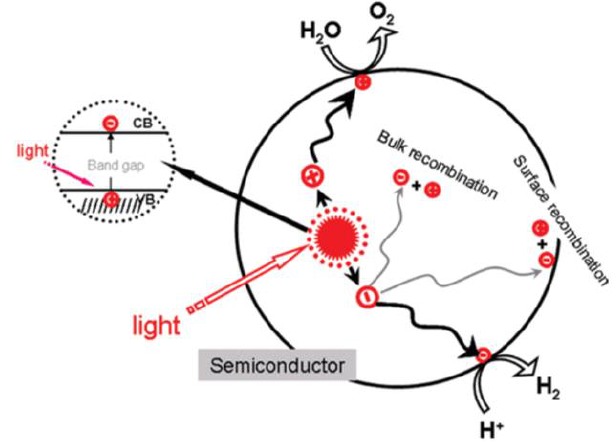
Figure 4. Representation of photocatalytic water splitting with semiconductors. Reprinted with permission from [65]. Copyright 2010 American Chemical Society.